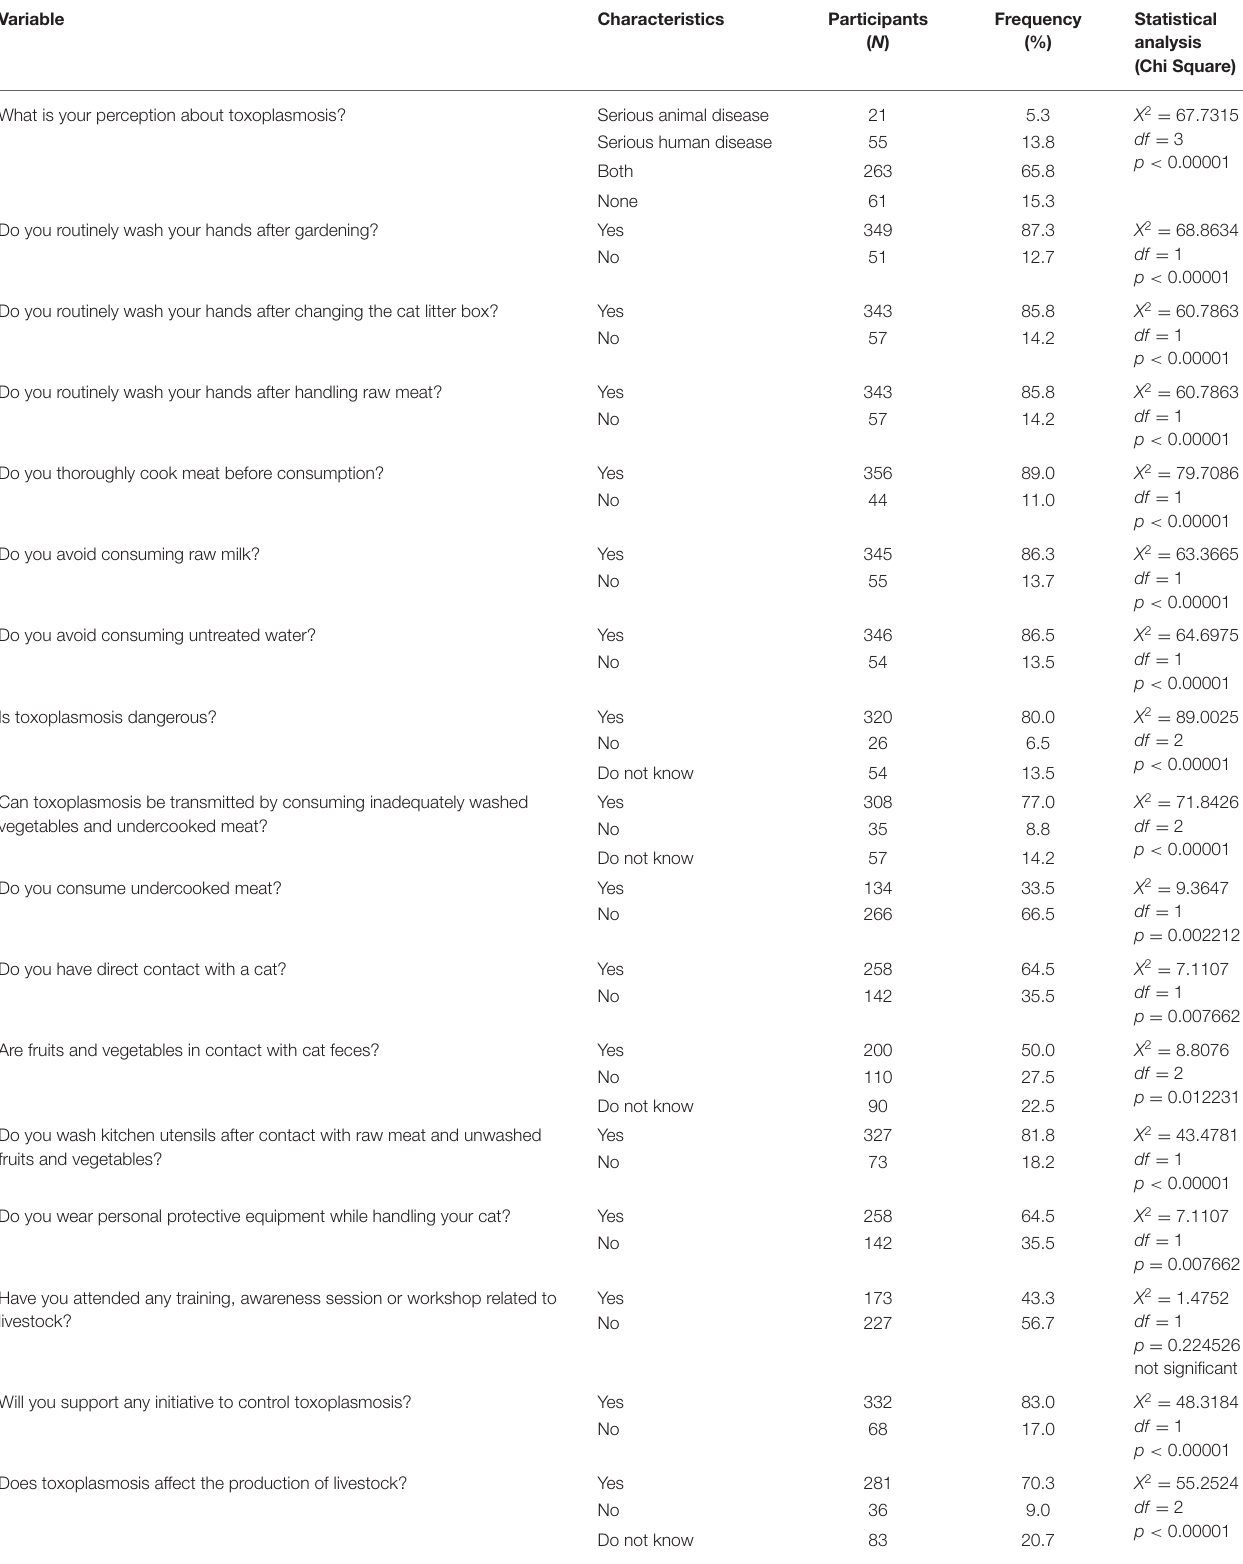
TABLE 3 | Attitudes toward